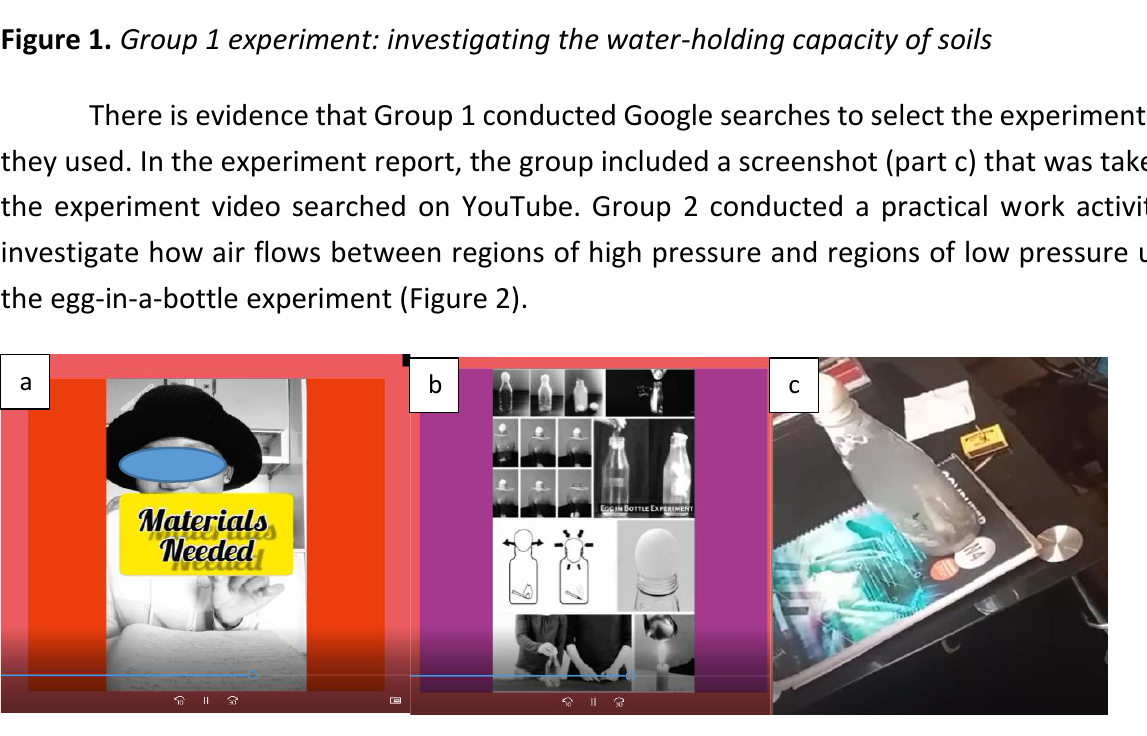
Figure 2. Group 2 experiment: investigating the flow of air between regions of high and low